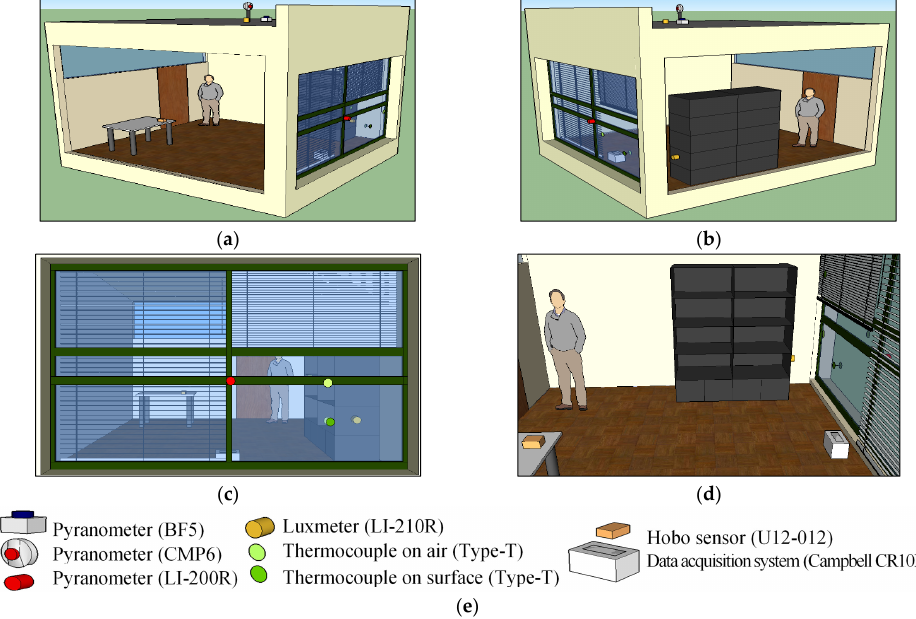
Figure 6. Location (in the reference office and on the flat roof) of the measuring equipment used in the experimental campaign: ( a ) south view; ( b ) east view; ( c ) glazing system outdoor view (southeast); ( d ) indoor view of the office room; ( e ) legend of the representation of the experimental equipment.